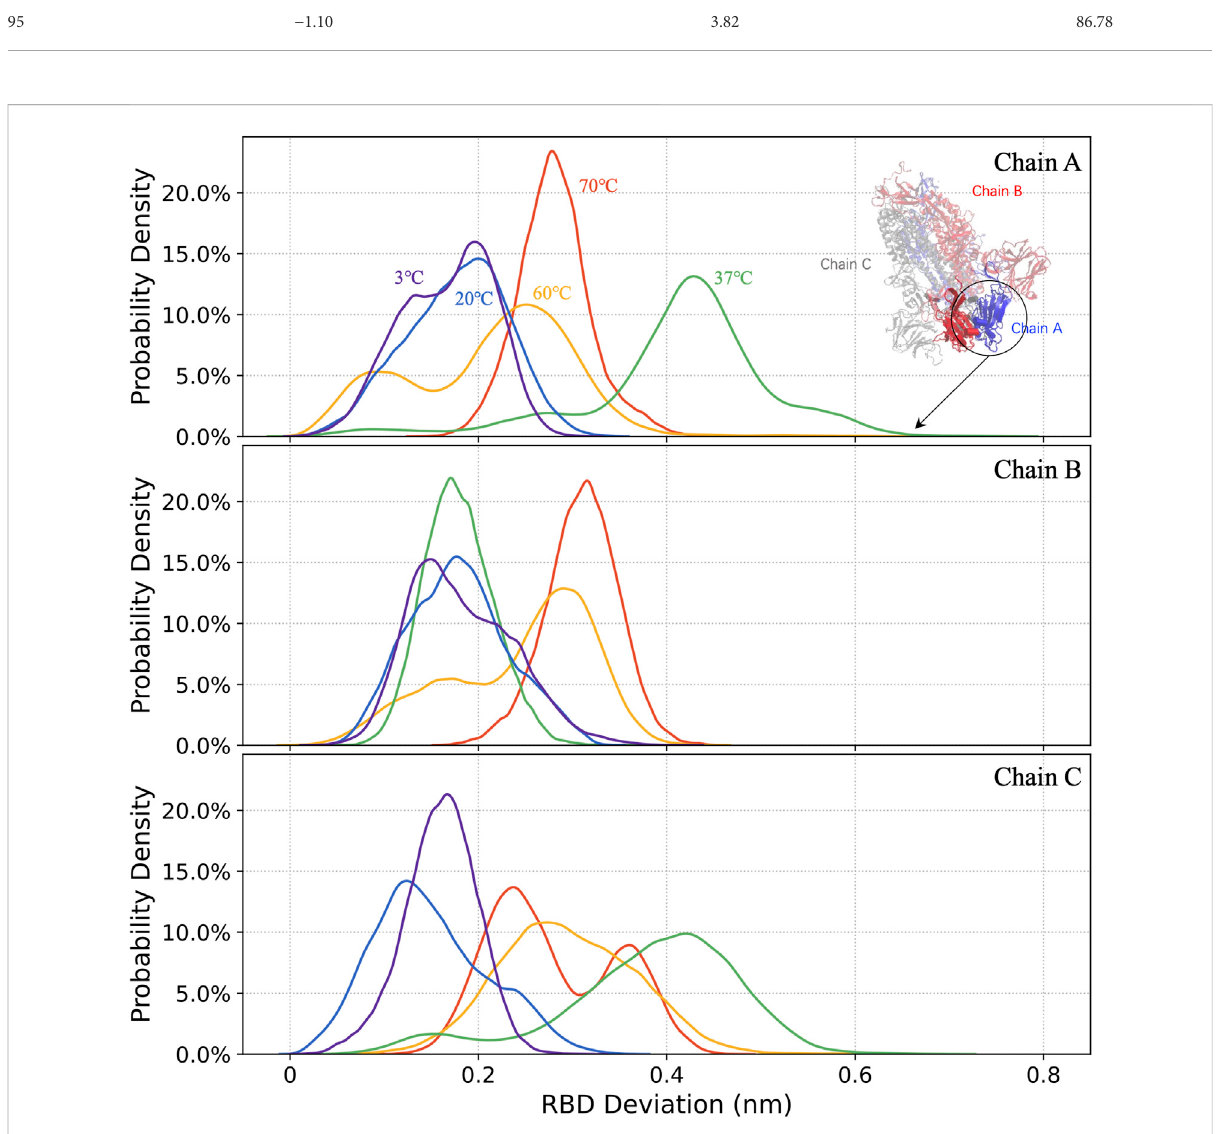
FIGURE 7 The distribution of RBD deviations in chains A, B, and C (from top to bottom) at 3 ° C, 20 ° C, 37 ° C, 60 ° C, and 70 °